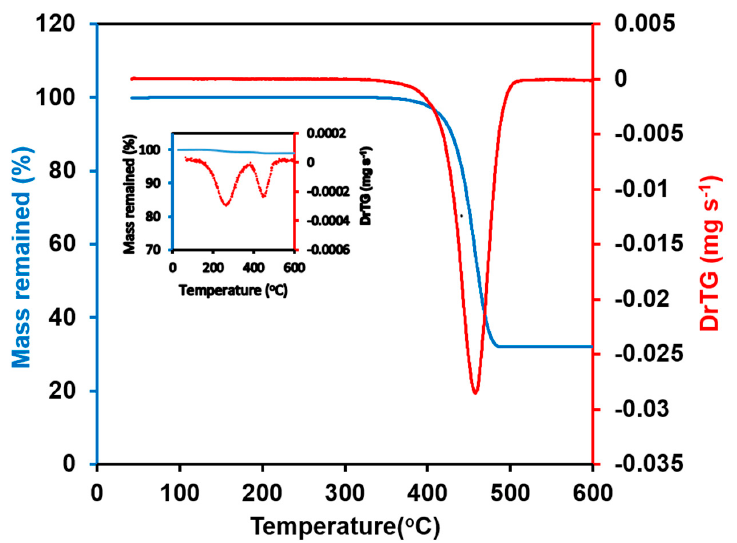
Figure 5. Thermogravimetric analysis (TGA) of LLCZN/PEO/LiPF 6 composite and the insert is pristine LLCZN powder.